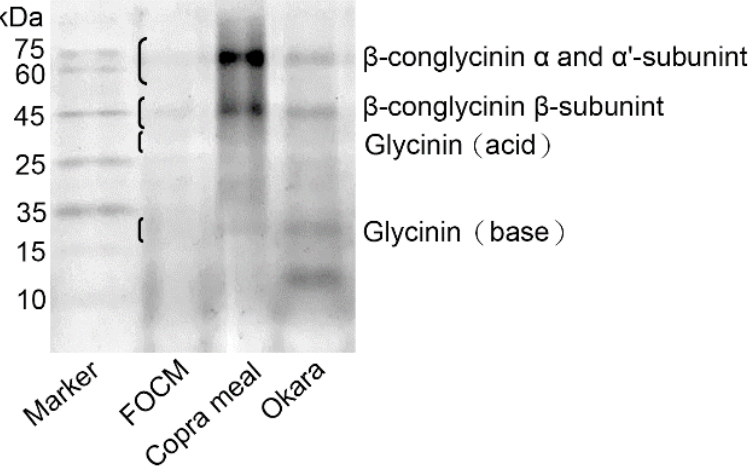
Figure 4. Effect of SSF on the soy globulins contents of okara and CM.